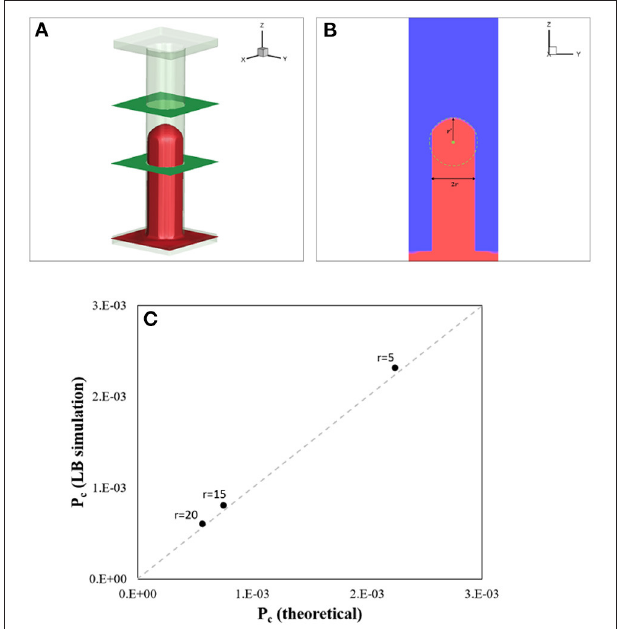
FIGURE 2 | A validation of LB simulation on a simple piston-type displacement in a cylindrical tube for calculation of local capillary pressure: (A) CO 2 is in red, brine is transparent, and the green planes define the bounds of calculation volume. (B) Cross-sectional view parallel to yz-plane through the center of tube to capture the radius of interface. (C) Comparison of calculated P c from LB simulation and theoretical P c from Young-Laplace equation on different radii of a cylindrical